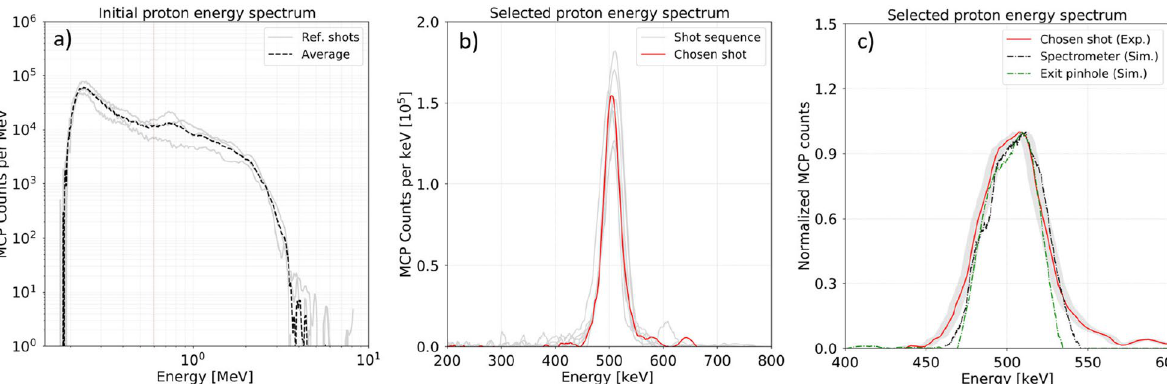
Figure 3. Spatial sampling of experimental spectra measured with magnet spectrometer. ( a ) Several example spectra obtained in configuration of no selection featuring reference initial proton spectrum with cut-off energy of 4 MeV (3000 V MCP Voltage). ( b ) The selected proton beam spectra (light-grey curves) obtained in full ∼ selection using 20 µ m entrance slit and 20 µ m exit pinhole (5000 V MCP Voltage). The chosen shot represents the typical spectrum (red solid curve). ( c ) Comparison of the chosen shot with synthetic proton spectrum obtained with MC FLUKA simulations at the exit pinhole (green dashed curve) and at spectrometer position (black dashed curve) in corresponding experimental geometry. Entrance slit Exit